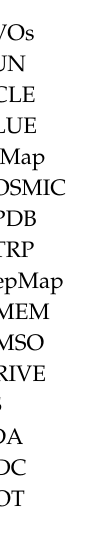
Figure S1: The information of Figure 1D on HRAS expression and cisplatin resistance of bladder, Figure S2: Time- and dosage-related increase in the cytotoxic response of T24 cells to pterostilbene and each of the anticancer drugs, Figure S3: Pterostilbene enhanced biosensitivity of T24 cells to combination of carboplatin and gemcitabine, Figure S4: The e ff ect of pterostilbene on apoptosis of T24 cells treated with anticancer drugs, Figure S5: E ff ects of pterostilbene on autophagy of T24 and E7 cells treated with carboplatin and gemcitabine, Figure S6: E ff ect of autophagy inhibitors on apoptosis of T24 cells, Figure S7: E ff ect of autophagy inhibitors on senescence of T24 cells, Figure S8: The phosphorylation of RB protein in T24 and E7 cells, Figure S8: The phosphorylation of RB protein in T24 and E7 cells, Figure S9: the whole western blots (uncropped